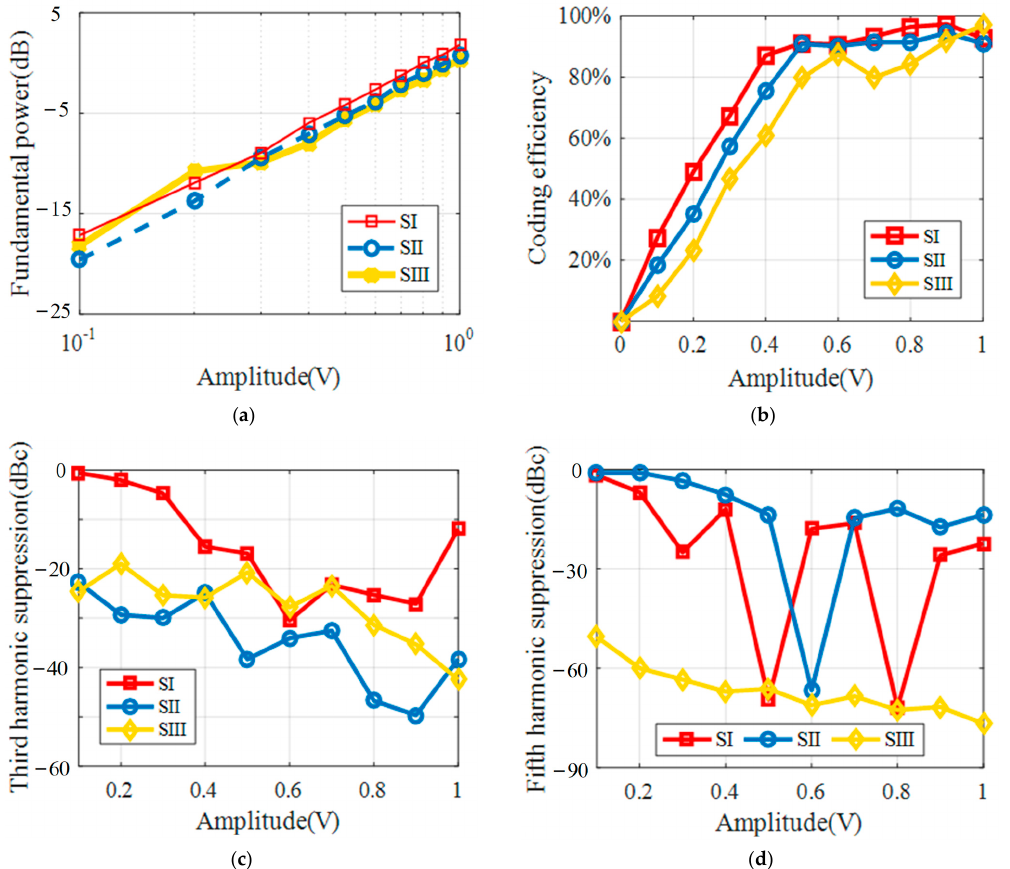
Figure 7. Simulated characteristics of SI, SII and SIII with the single-tone signal under different amplitude at 200 MHz carrier with T r = 1% ( a ) Fundamental power. ( b ) Coding efficiency. ( c ) Third harmonic suppression. ( d ) Fifth harmonic suppression.